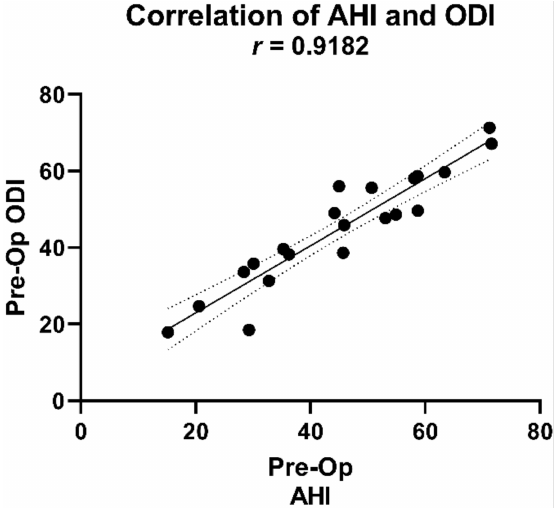
Figure 6. Correlation between the pre-operative AHI and ODI. AHI: apnea–hypopnea index; ODI: oxygen desaturation index; r : Spearman’s rank correlation